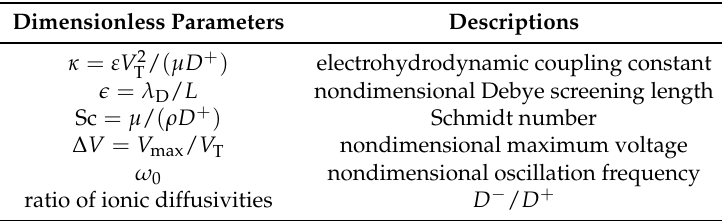
Table 1. Dimensionless parameters and their